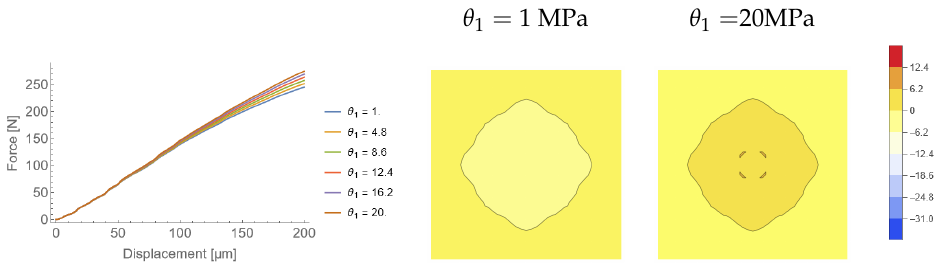
Figure 11. Sensitivity of LD curves and surface topographies to θ 1 in a wider range (other parameters were kept fixed). A difference with respect to the reference simulation is shown. Size of the map is 2.4 µ m × 2.4 µ m. The legend presents the colors related to a difference value in µ